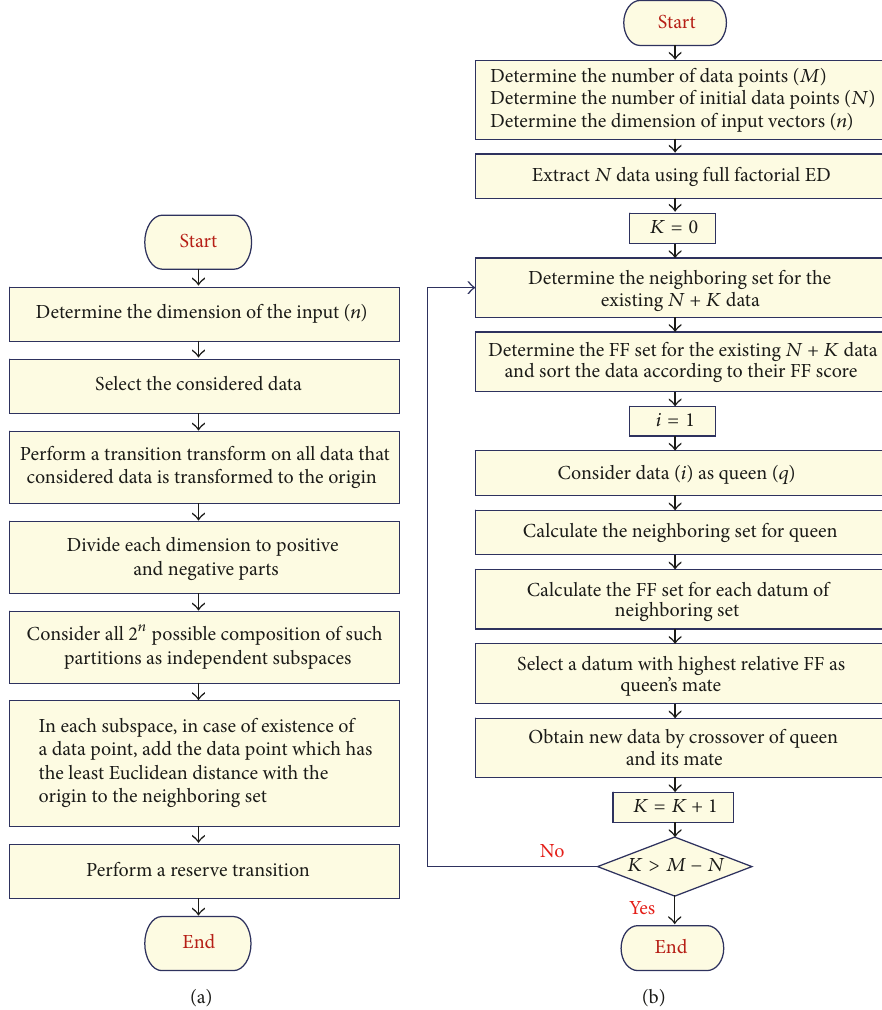
Figure 1: (a) Flowchart of the neighbor selection algorithm. (b) Flowchart of the proposed